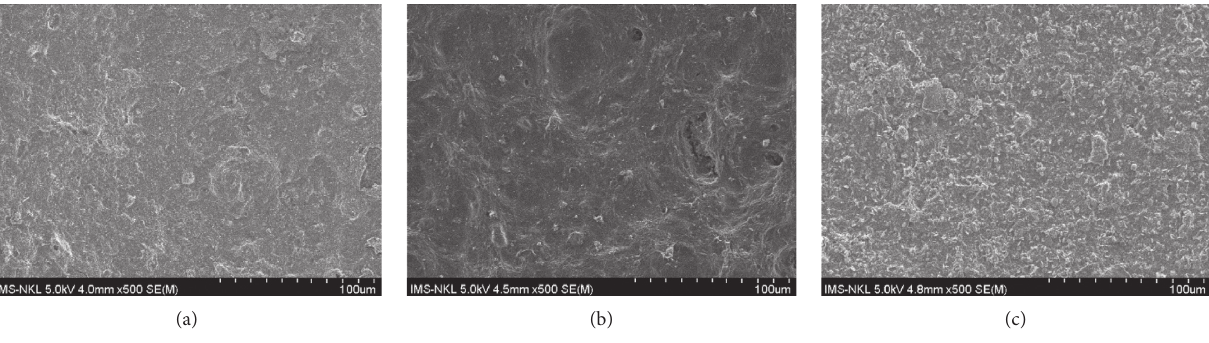
Figure 12: SEM images of the electrode-coated CI-EtOH (1/1) (a), CI-EtOH (1/0.5) (b), and CI-EtOH (1/2)